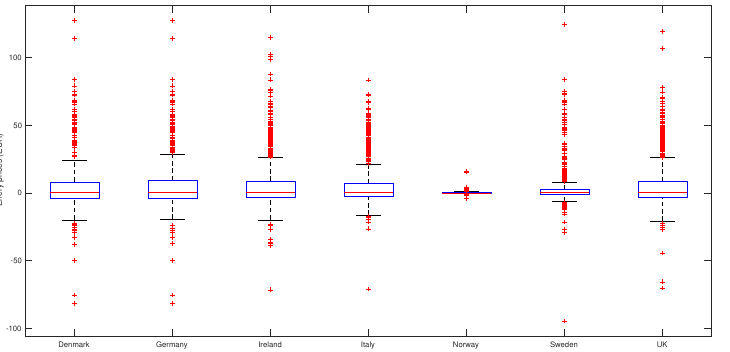
Figure 13. Comparison of wind speed and wind generation potential time series forecasting.